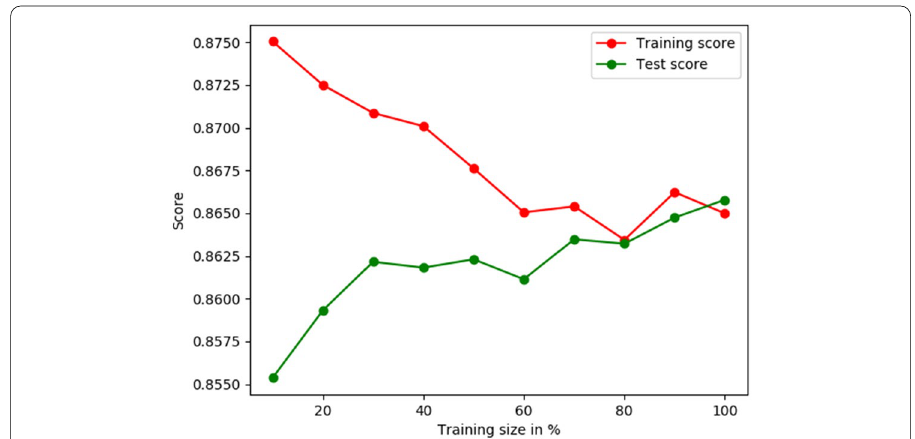
Fig. 4 Learning curve of the V-RNN with reduced training size on the ASR error detection